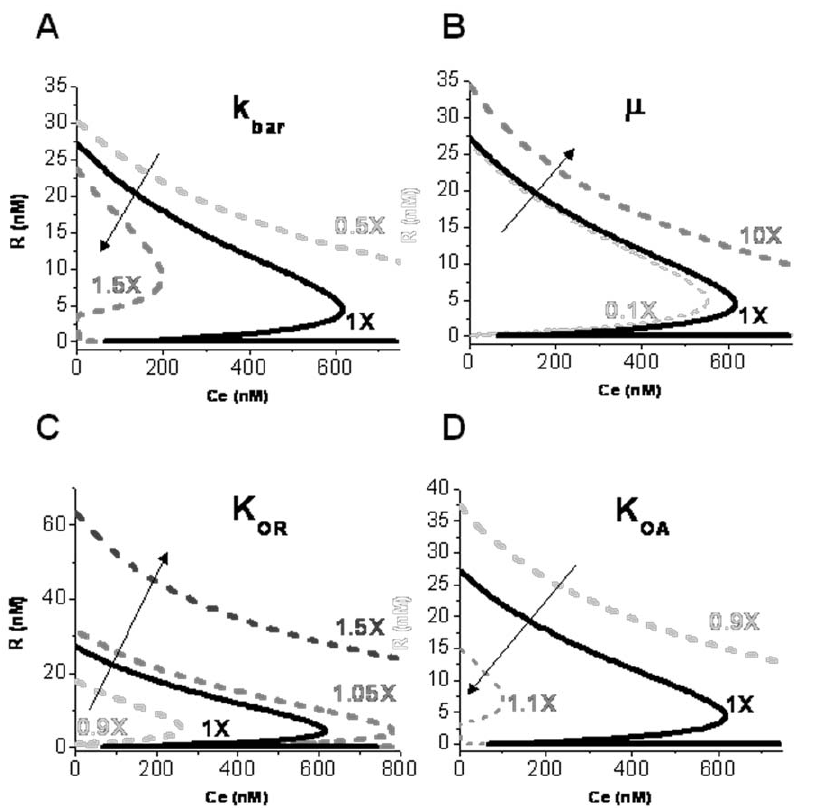
Figure 6. Effect of single-parameter perturbation on steady state response of ScbA-ScbR system to constant extracellular SCB1. Results show the effect of varying one (indicated) parameter while keeping the rest constant at the nominal values listed in Table 3. The solid black line (1X) in each plot corresponds to the nominal parameter values. Effect of changing parameters: ( A ) Sense: antisense RNA interaction rate constant, ( B ) growth rate and ( C–D ) equilibrium rate constant corresponding to binding of repressor R to operator sites O R (C) and O A (D) on the steady state response of ScbR to extracellular SCB1.